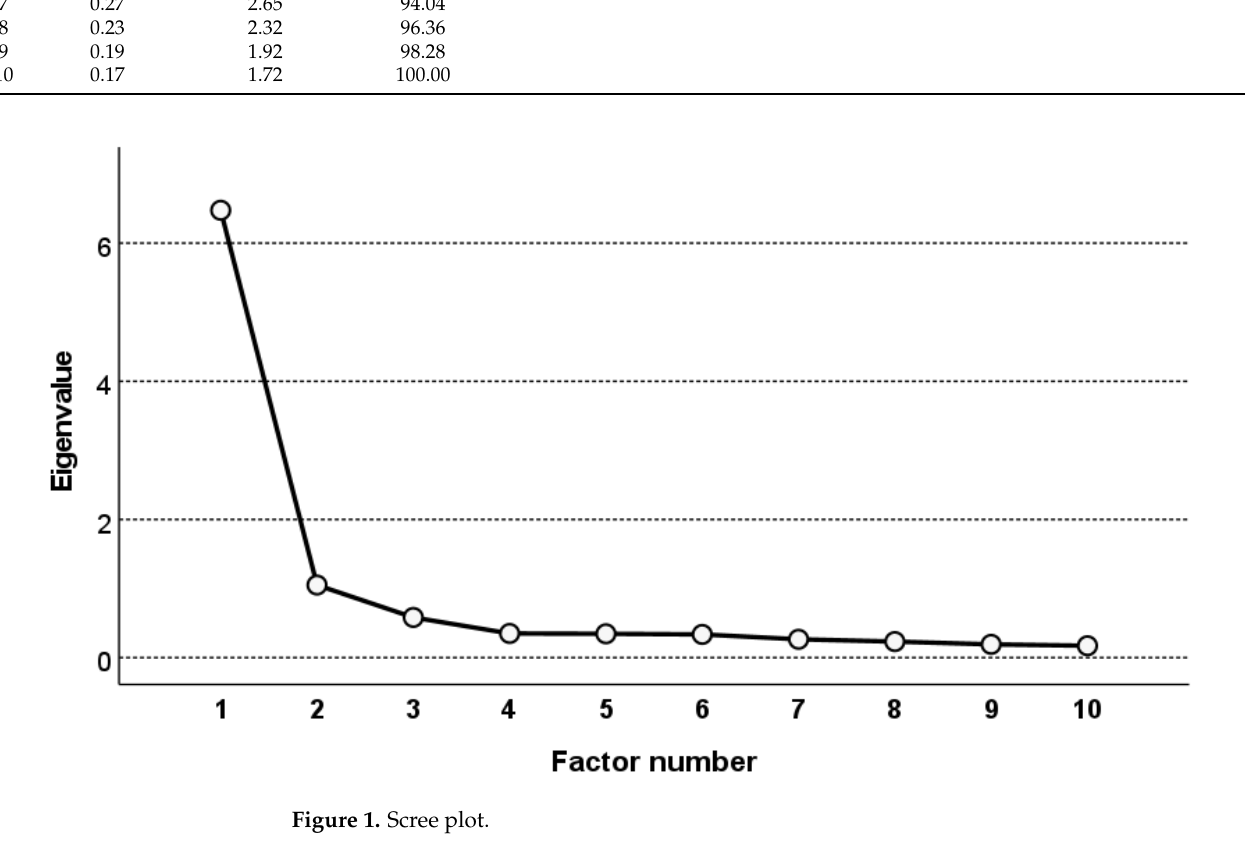
Figure 1. Scree plot.